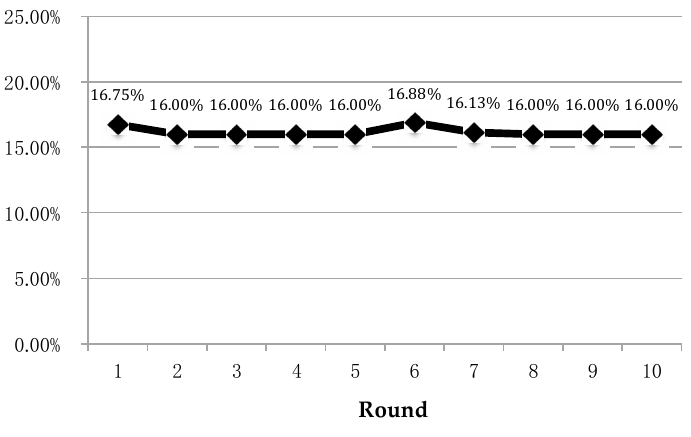
Figure 4. Average percentage of enrolled land per round.